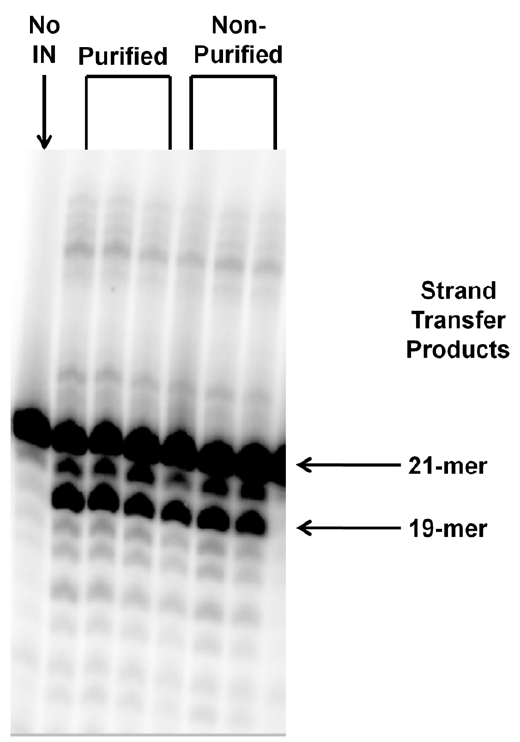
Figure 3. IN in inclusion body extracts is enzymatically active. The activity of IN in processed expression bacterial lysate is identical to that of purified IN, suggesting that full purification of IN is not a necessary step for in vitro analysis of function. Purified and processed INs were titrated from 200–600 nM. Both enzymes were highly active even at the lowest concentration tested. Identically processed expression cell lysate without IN (‘‘No IN,’’ first lane) lacks nonspecific nuclease